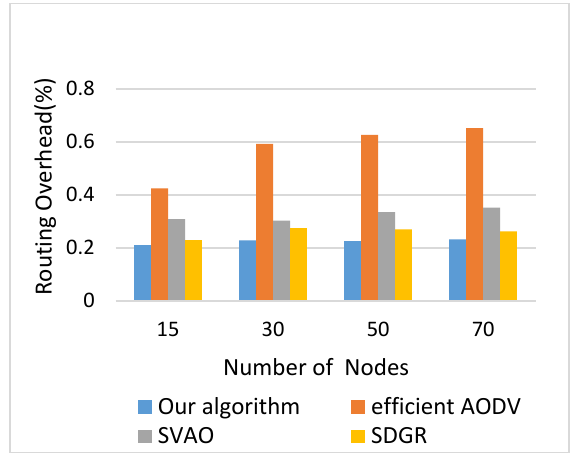
Figure 6. Routing overhead comparison.